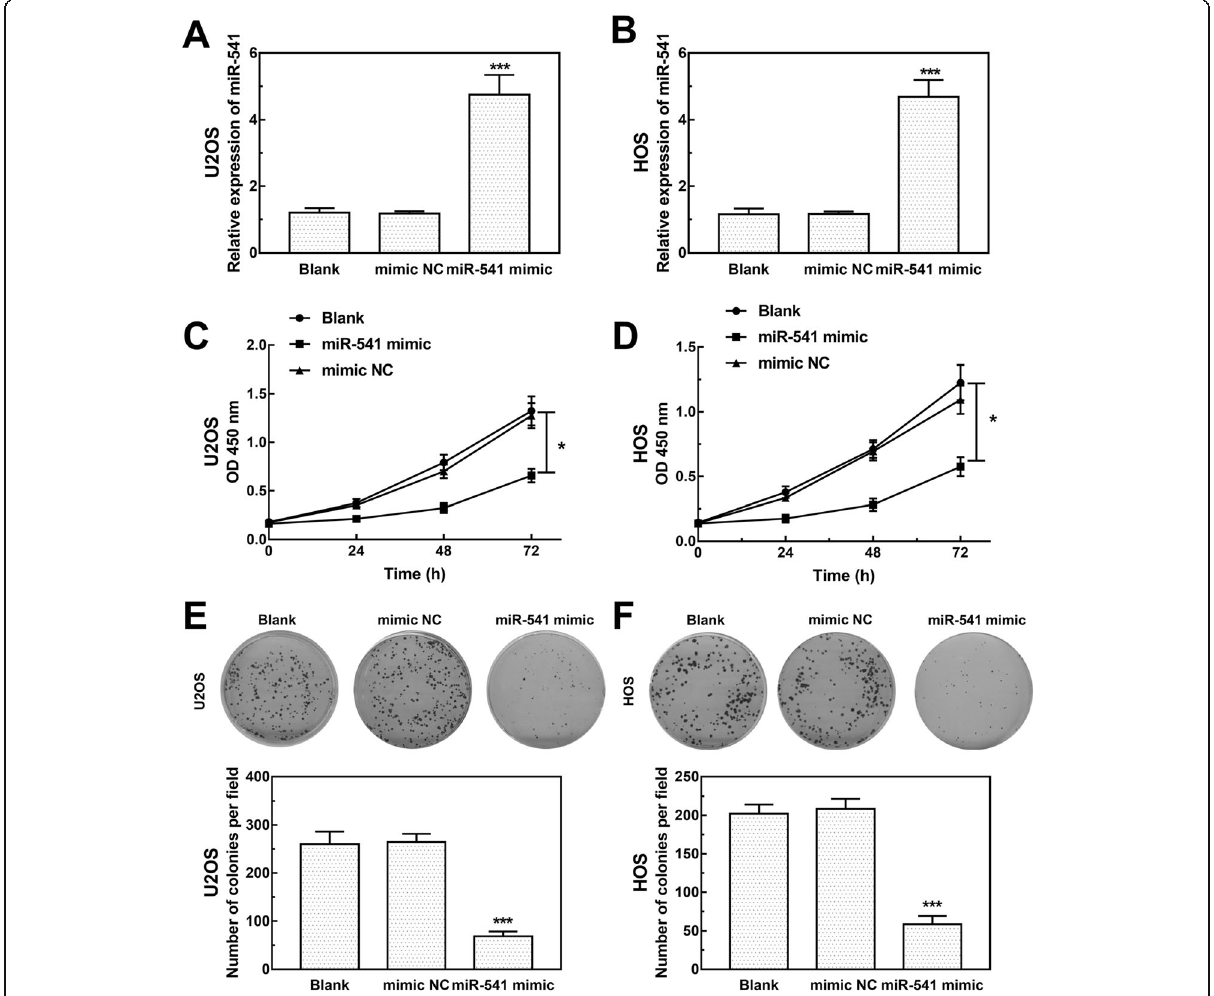
Fig. 3 Effects of miR-541 on OS cell proliferation, migration, and invasion of OS. a and b The expression of miR-541 in U2OS and HOS transfected with miR-541 mimic or miR-541 mimic NC (*** P < 0.001). c and d Cell proliferation of U2OS and HOS transfected with miR-541 mimic or miR-541 mimic NC (* P < 0.05). e and f Colony formation assay results for U2OS and HOS cells transfected with miR-541 mimic or mimic NC (*** P <